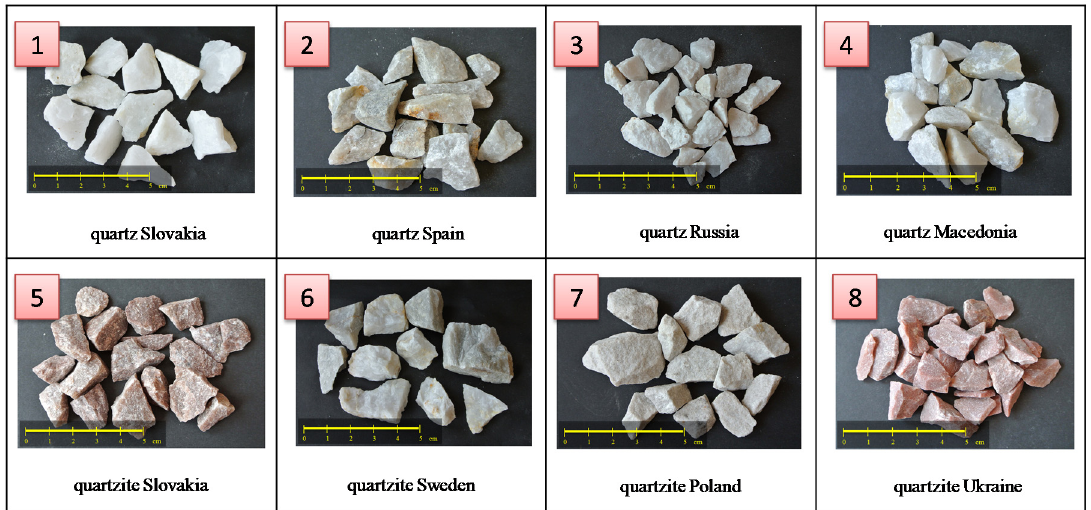
Figure 3. Illustration of samples for experimental study. Legend to Figure 3: quartz Slovakia = Švedlár, quartz Spain = Erimsa, quartz Russia = Ta č alin, quartz Macedonia = Stepanci, quartzite Slovakia = Krn č a, quartzite Sweden = Dalbo, quartzite Poland = Bukowá Góra, quartzite Ukraine = Ovru č .